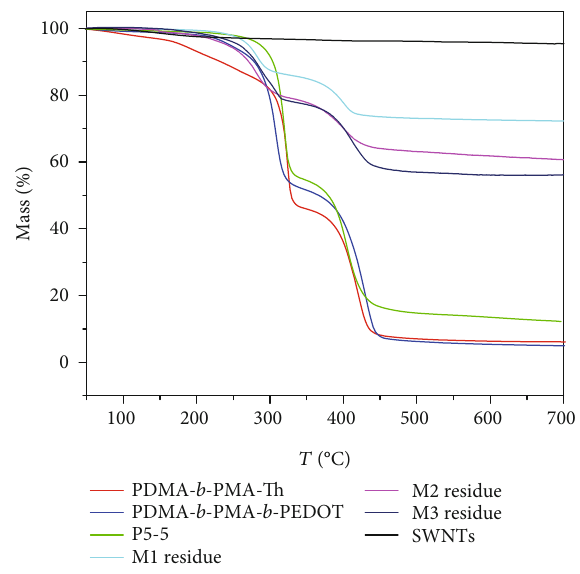
Figure 4: TGA curves of the modi fi ers, modi fi ed-SWNT residues, and pristine